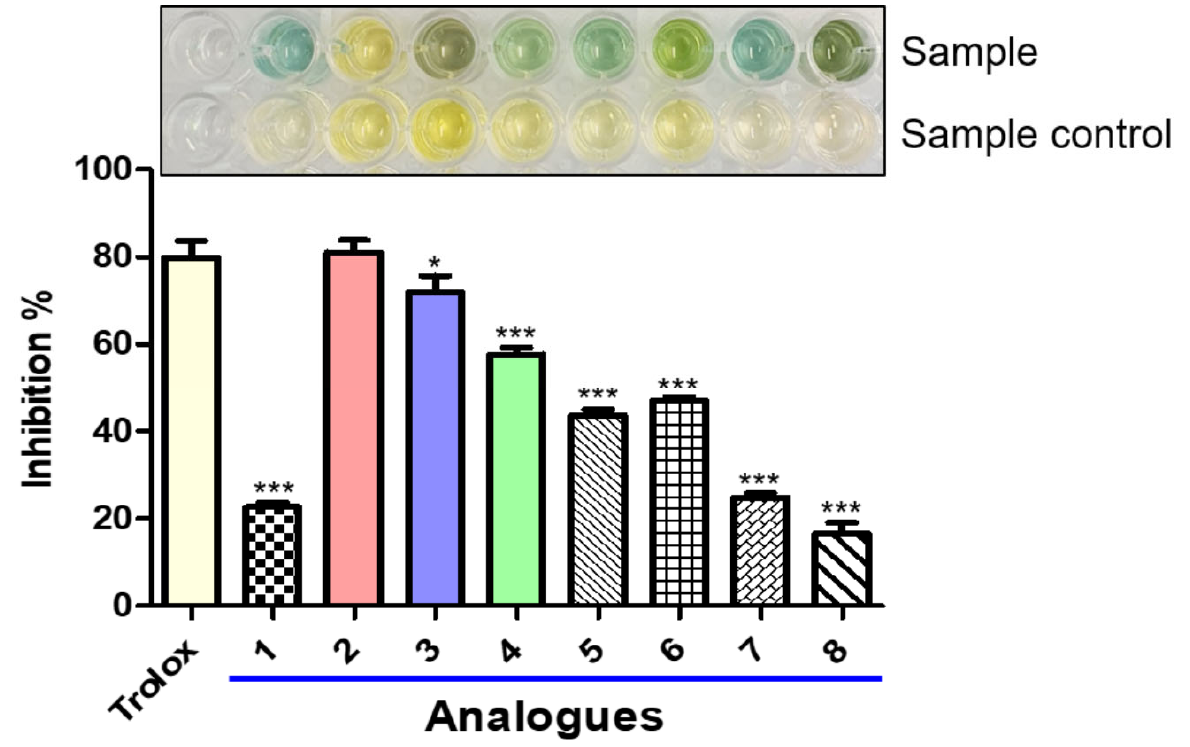
Figure 9. Effects of analogs 1 – 8 on ABTS radical scavenging activity. Trolox was used as the positive control. Test samples and Trolox were assayed at a final concentration of 100 µ M. ABTS radical solution with an optical density of 0.70 ± 0.02 at 734 nm was used, and the absorbances of test samples were measured at 734 nm after standing for 2 min in the dark at RT. Experiments were conducted independently 3 times, and asterisks (*) represent significant differences between analogs and Trolox. * p < 0.05, *** p < 0.001 for Trolox versus analog 1 – 8 .